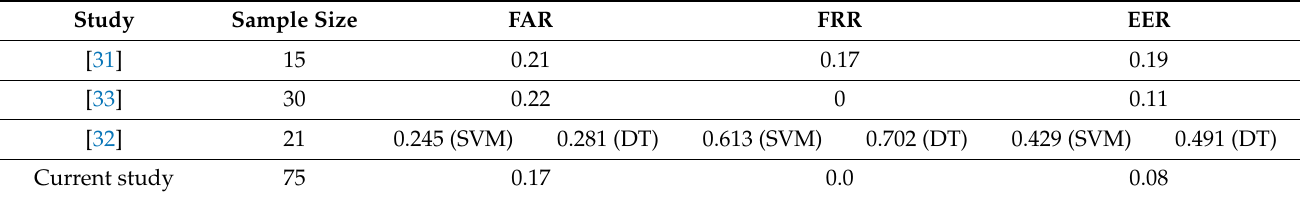
Table 7. Summary of comparison